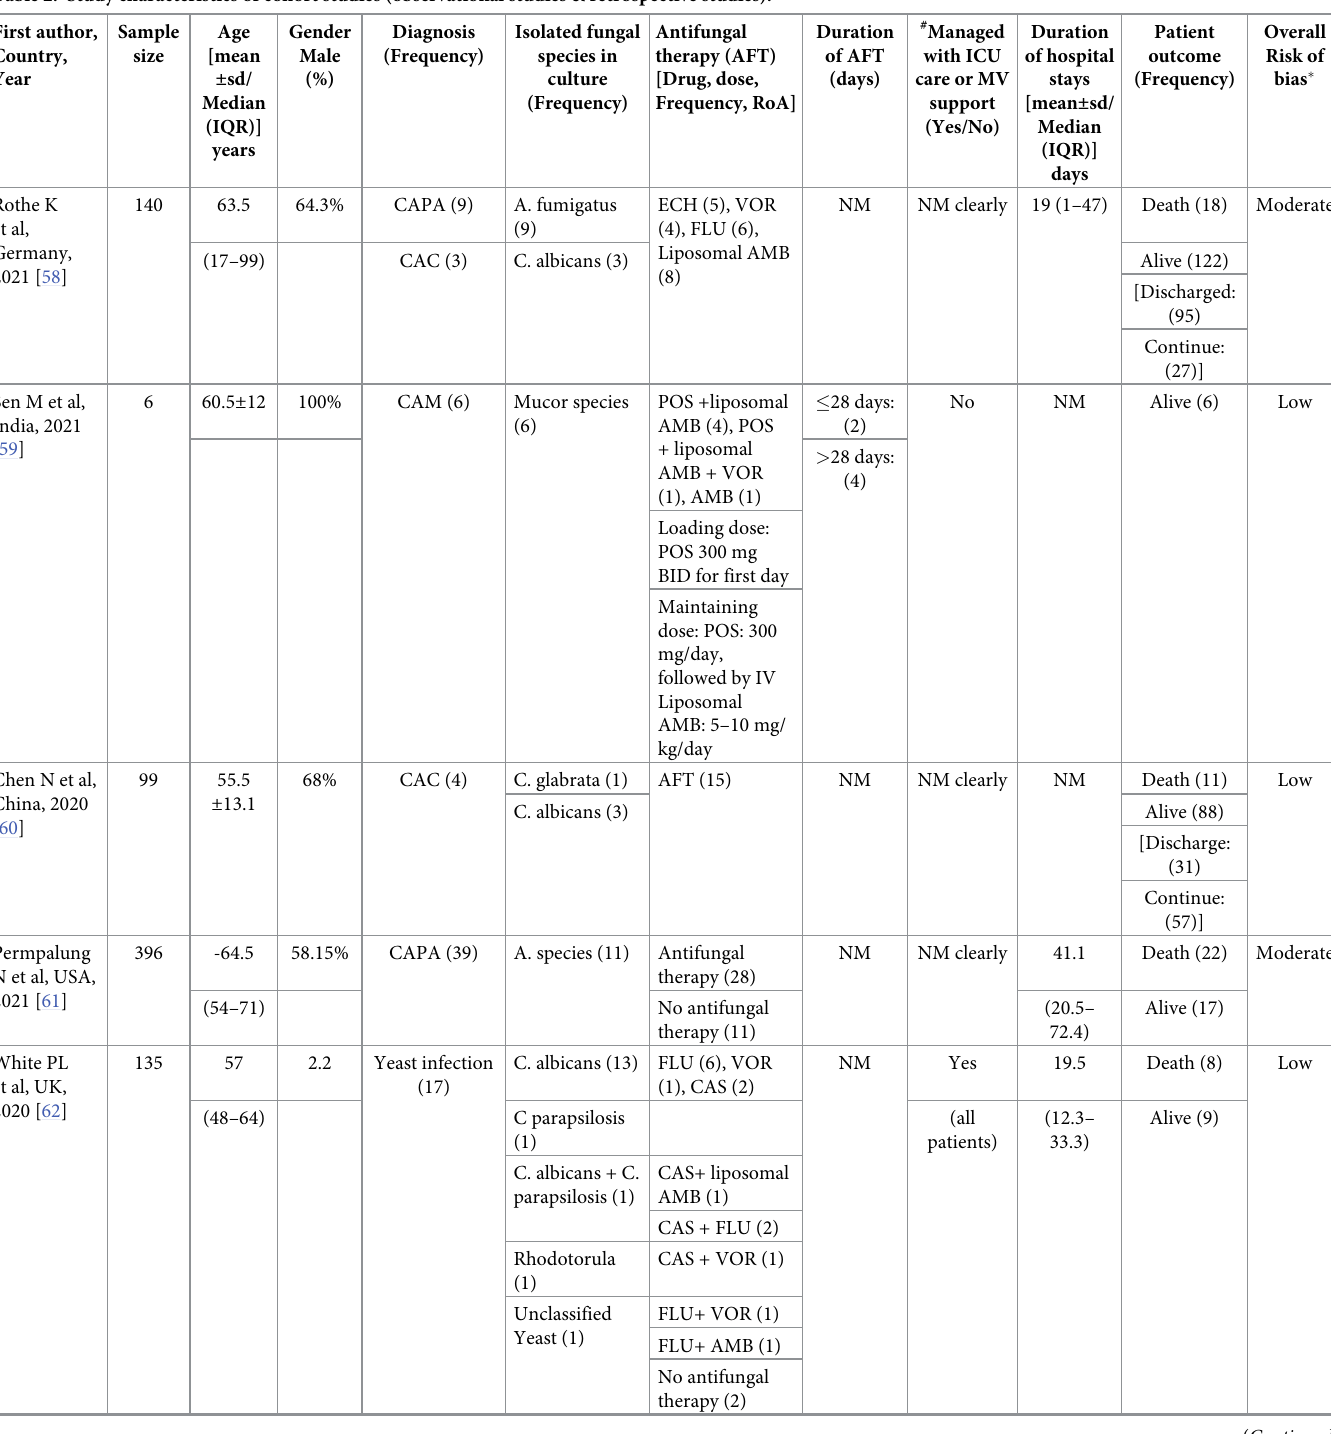
Table 2. Study characteristics of cohort studies (observational studies & retrospective